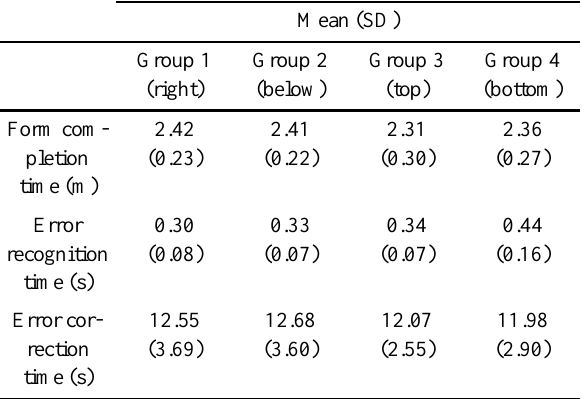
Performance of the participants in completing the